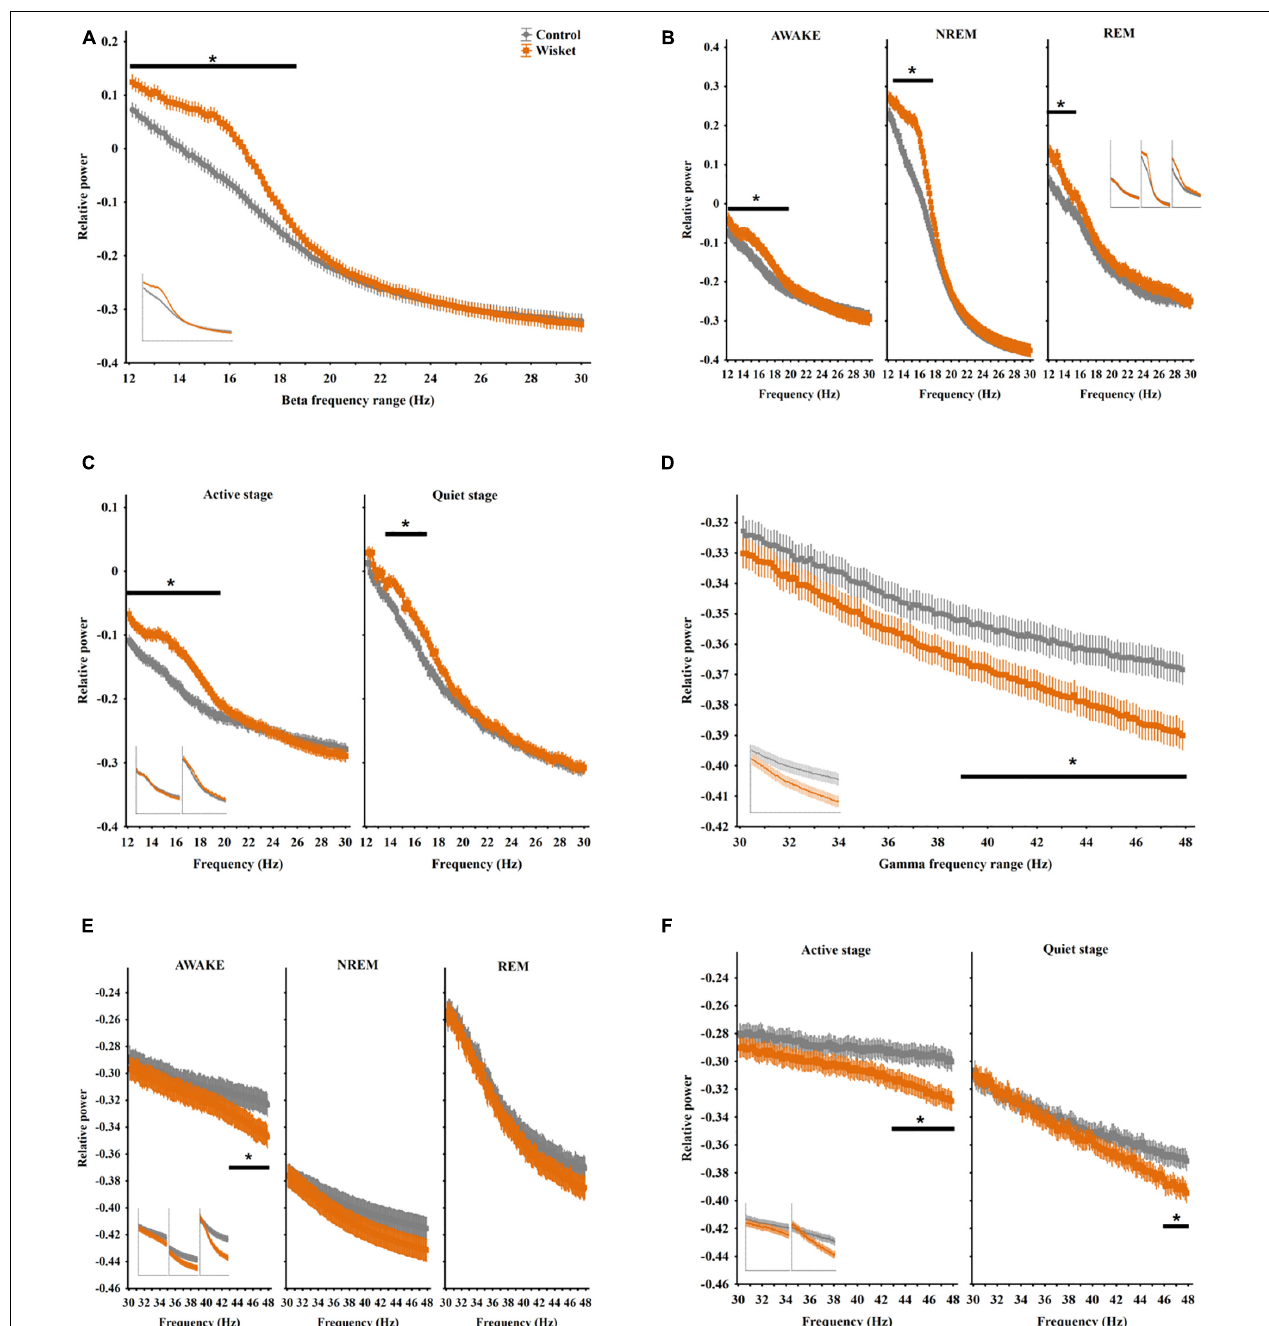
FIGURE 3 | Relative EEG power differences between the two groups at the beta and gamma frequency bands. (A) Total relative beta power (12–30 Hz). (B) Beta power in different stages. (C) Beta power in active and quiet awake substages. (D) Total relative gamma power (30–48 Hz). (E) Gamma power in different stages. (F) Gamma power in active and quiet awake substages. Curves inserted in reduced size show the results obtained from unmatched control and Wisket animals. The symbol * shows significant ( p ◦ < ◦ 0.05) differences between the two groups.